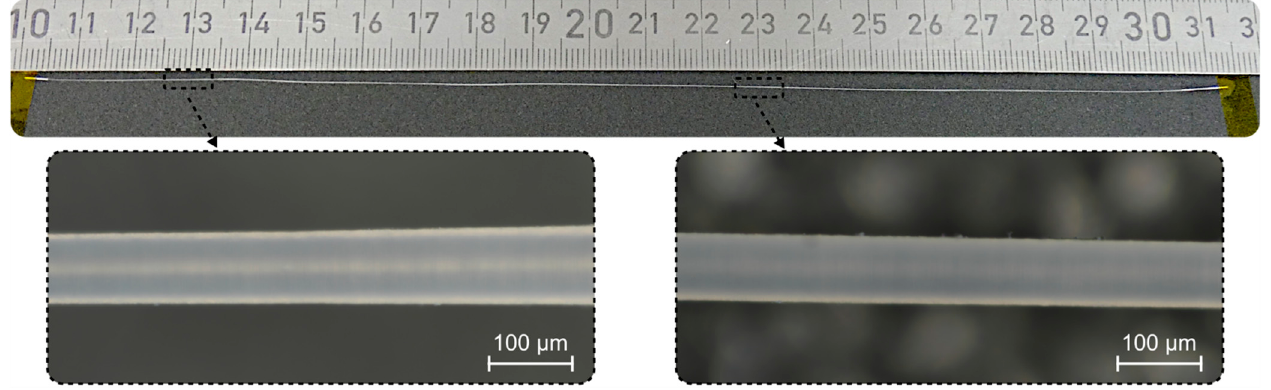
Figure 8. Sapphire fiber with an average outer diameter of 90 μ m over a length of 20 cm, fabricated via orthogonal scanning in combination with incremental rotation of the workpiece and constant workpiece feed. Both zoom-ins show exemplary microscopic images at different positions along the fiber.